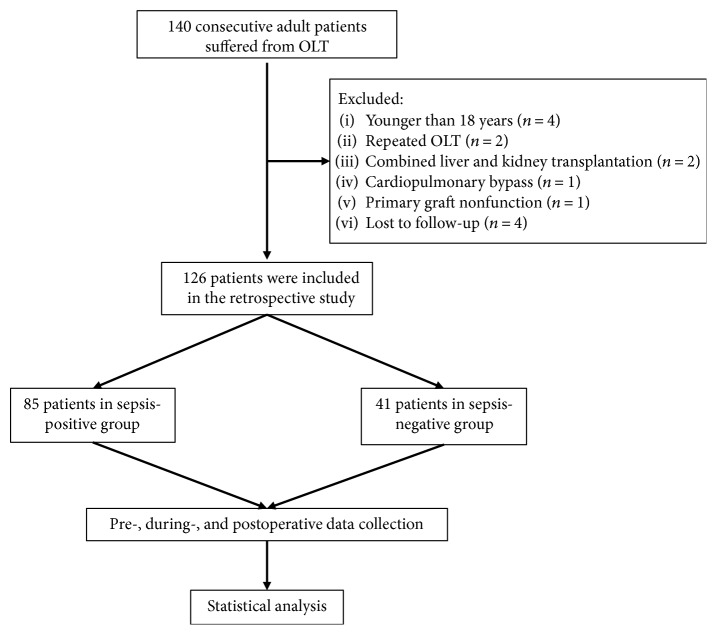
Study population and exclusion criteria in the current retrospective study.